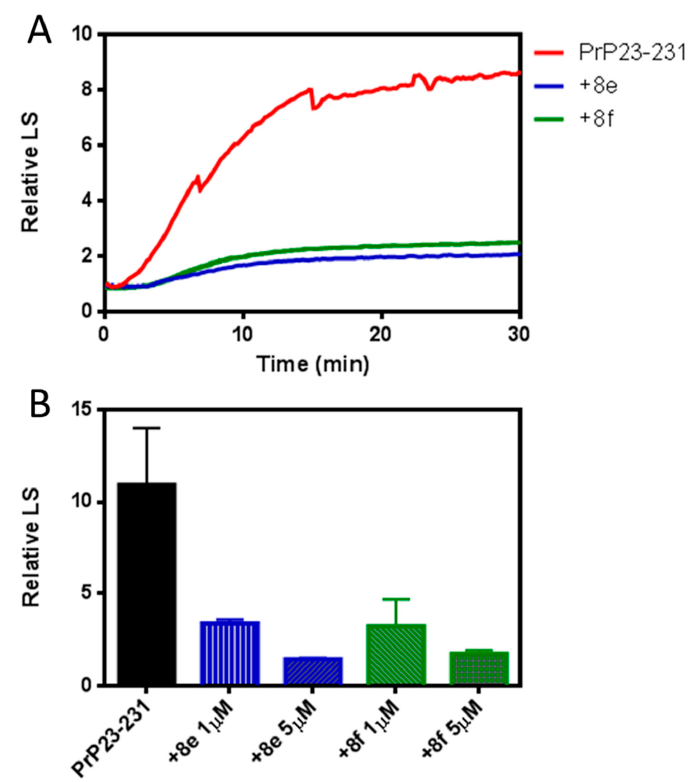
Figure 4. 8e and 8f decrease PrP aggregation induced by high temperature. ( A ) Recombinant PrP23-231 (1 µ M) was incubated at 60 ◦ C in the absence (red line) or the presence of compounds (1 µ M), and light scattering (LS) was monitored over time. LS was represented relative to initial LS values at 25 ◦ C. Representative data of three independent experiments. ( B ) Comparison of PrP23-231 steady-state aggregation at 60 ◦ C (red bar) and in the presence of compounds at 1:1 (1 µ M) and 1:5 (5 µ M) molar ratios. Data are represented as the mean of three independent experiments, and error bars represent the standard deviation.